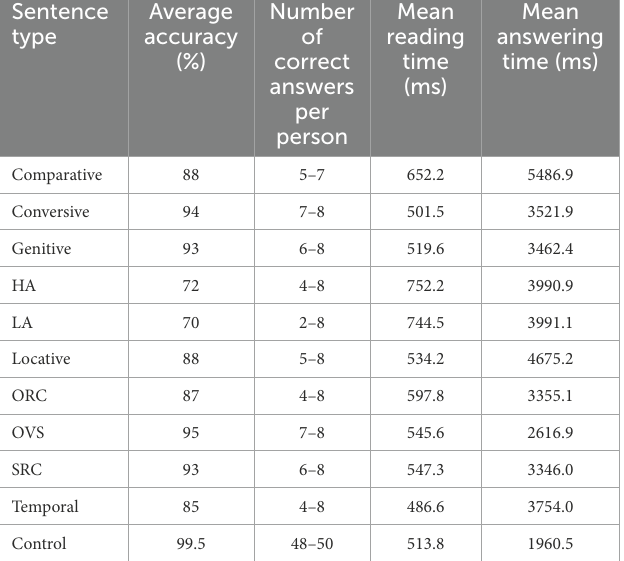
TABLE 1 Average word-by-word reading times, question answering times and accuracy in the pilot study. Sentence